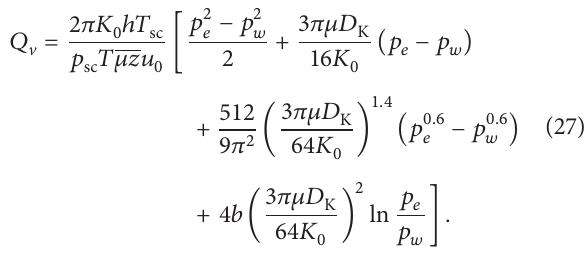
Figure 4: Sketch map of hydraulic fracture